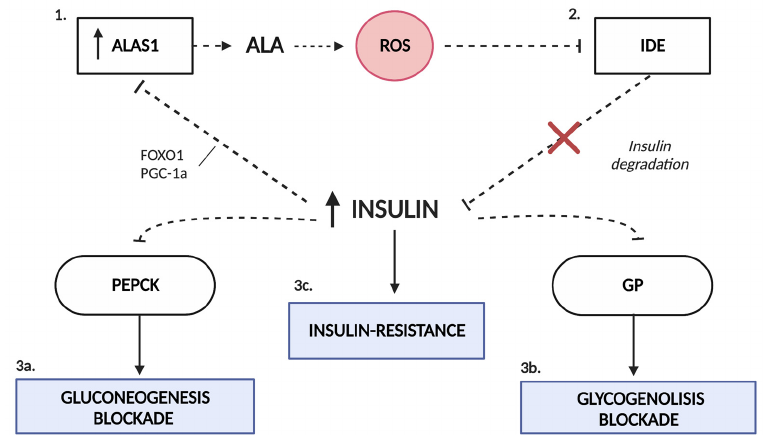
Figure 3. Interaction of carbohydrate metabolism and the heme biosynthetic pathway. The state of oxidative stress produced by the excess of ALA in porphyria (1) favors the dysfunction of the enzyme glutathione-insulin transhydrogenase, responsible for the degradation of insulin (2). Hyperinsulinemia alters the pathways of gluconeogenesis (3a) and glycogenolysis (3b) due to the inhibition that insulin exerts on PEPCK and GP enzymes. This increase in serum insulin favors the inhibition of ALAS1 by the disruption of the FOXO1-PGC1 α complex (1). In addition, it is likely that it promotes the development of insulin resistance in porphyric patients (3c). ALAS1, δ -aminolevulinate synthase 1; FOXO1, forkhead box O1; GP, glycogen phosphorylase; IDE, insulin-degrading enzyme; PEPCK, phosphoenolpyruvate carboxykinase; PGC1 α , proliferator-activated receptor γ coactivator 1 α ; ROS, reactive oxygen